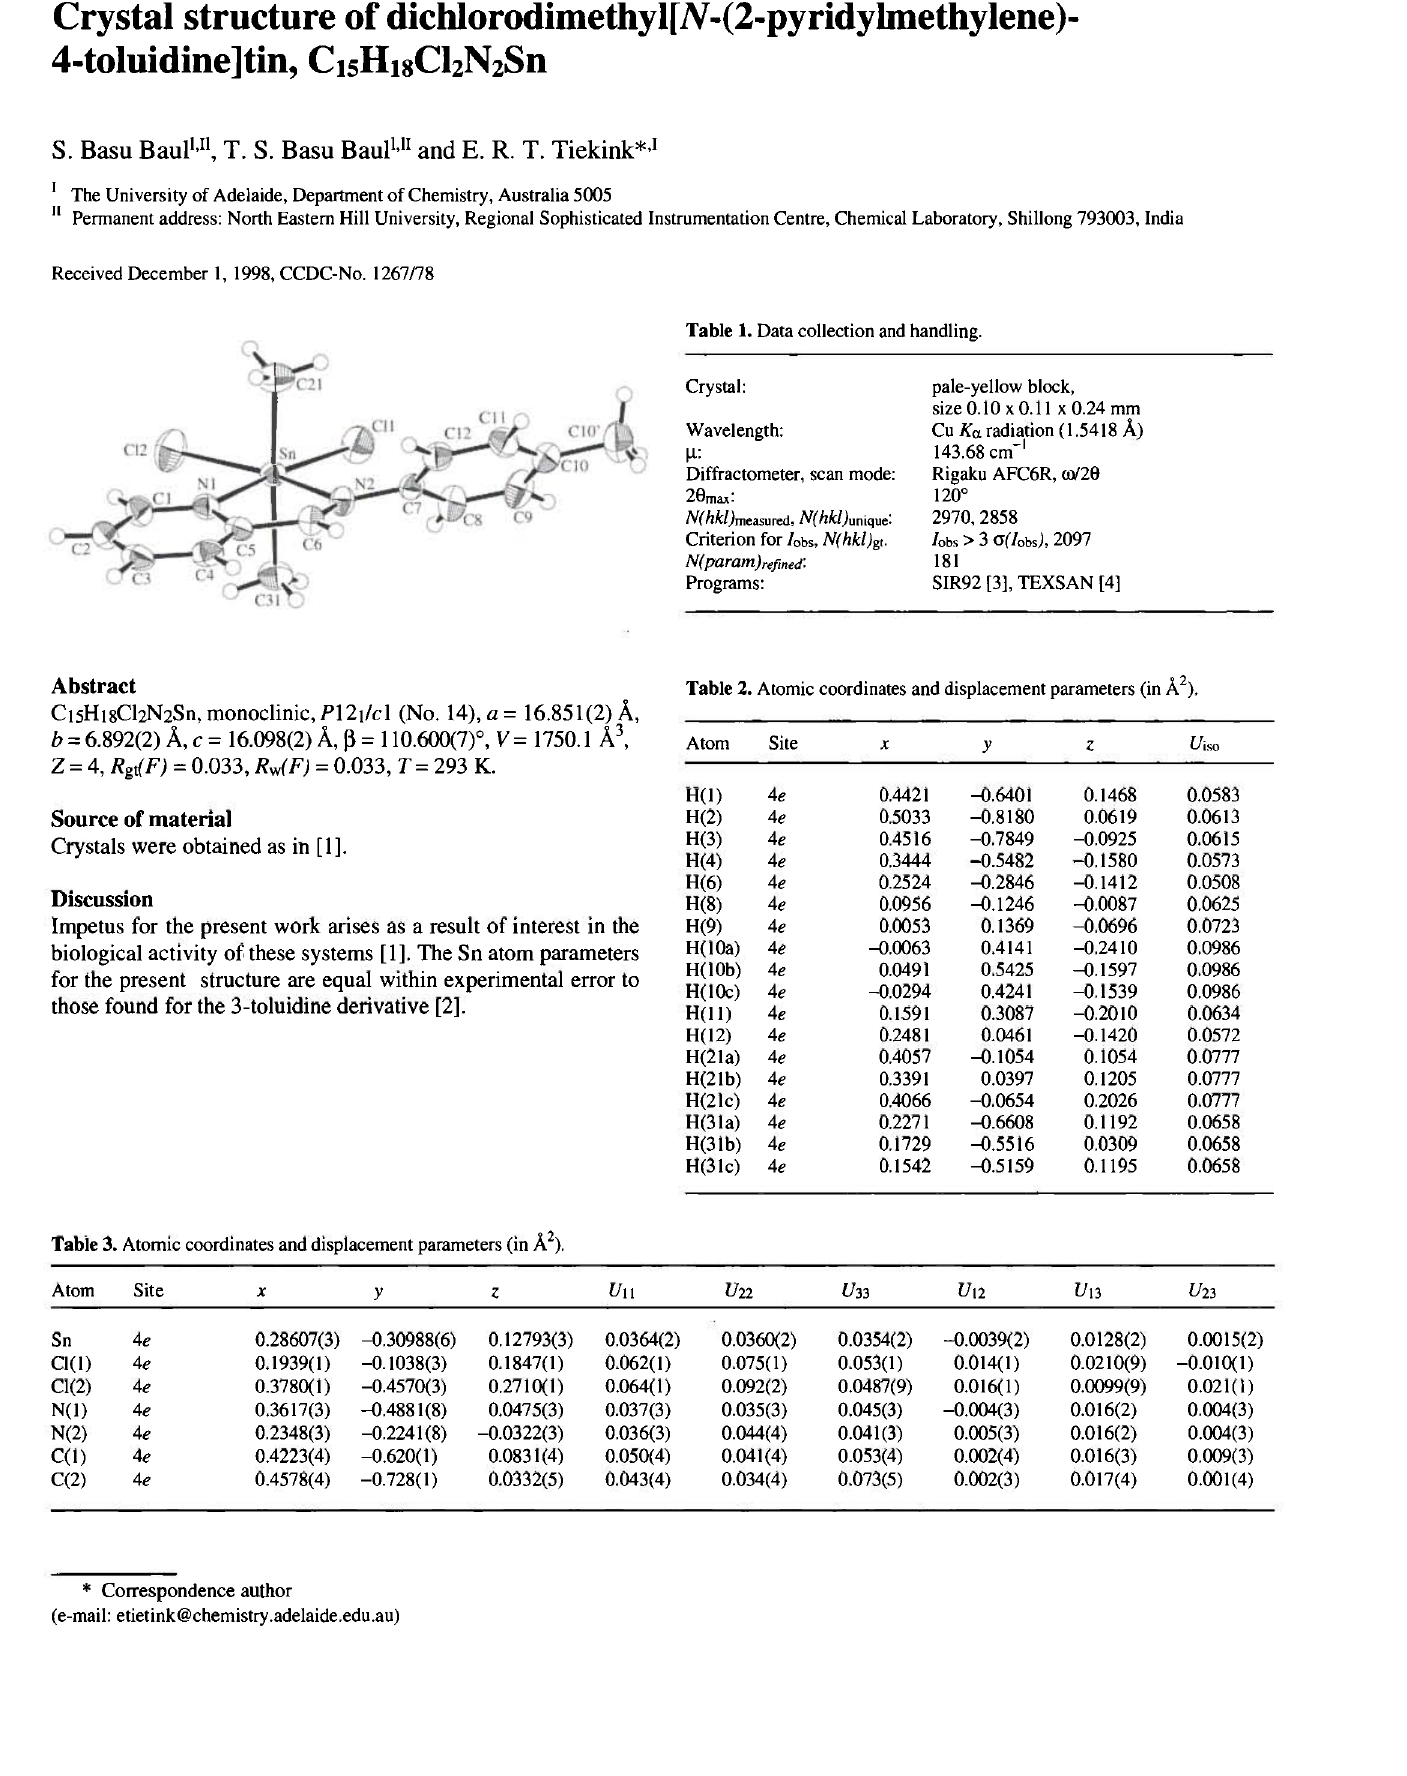
Table 1. Data collection and handling.